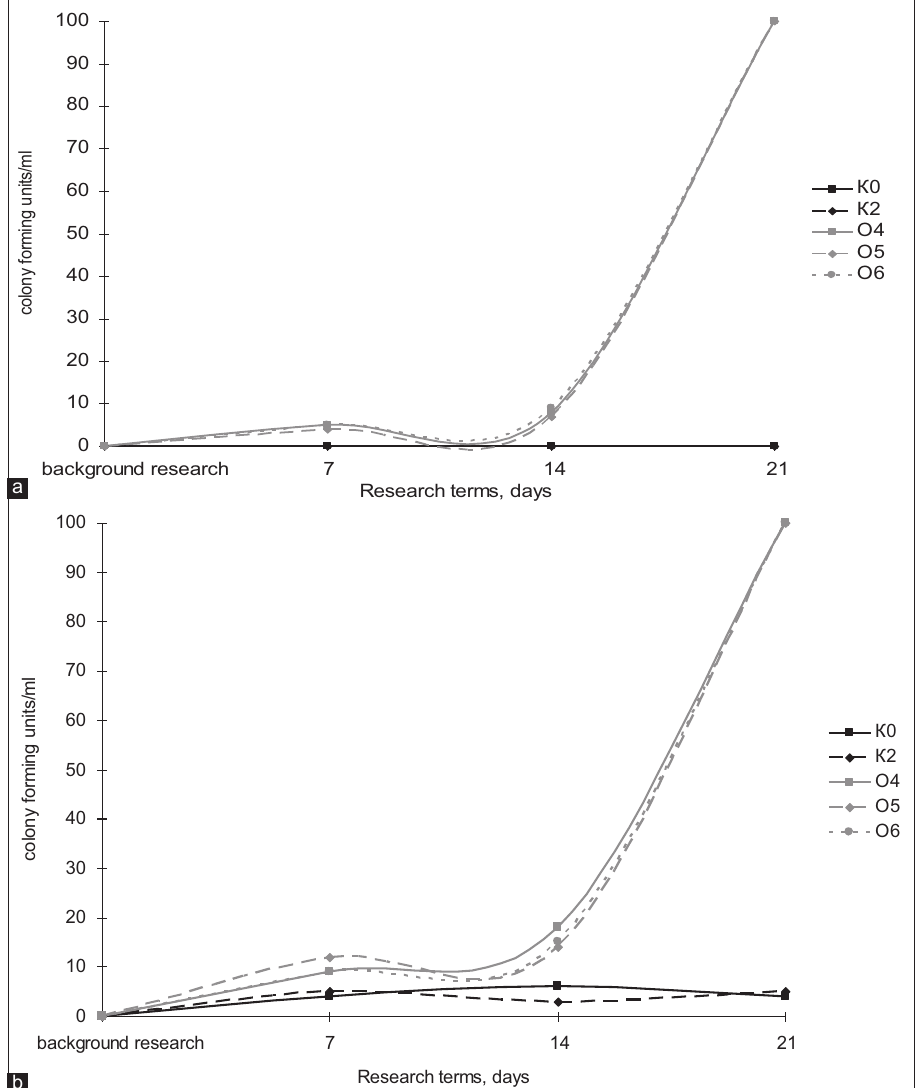
Figure-5: The total number of bacteria of the genus Bacillus in (a) blood and (b) feces of laboratory animals: К – background, К – control of the metal (Cu), О 0 2 “Bactisubtil” and